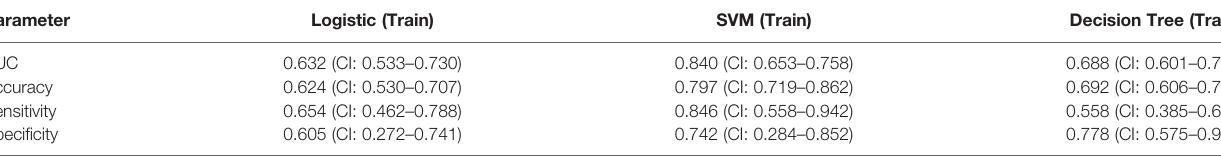
TABLE 3 | ROC curve analysis of three models in the training set. Parameter